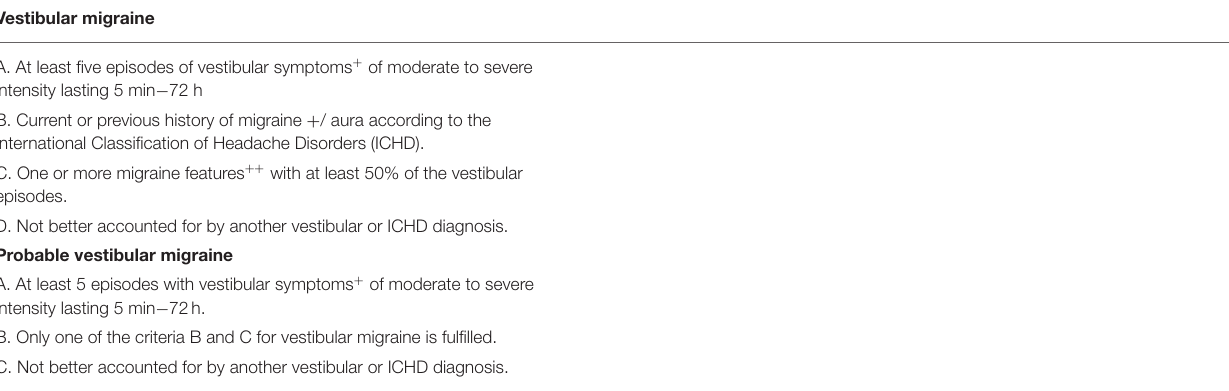
TABLE 1 | Diagnostic criteria of vestibular migraine from the 2012 International Headache Society and Bárány Society. Vestibular